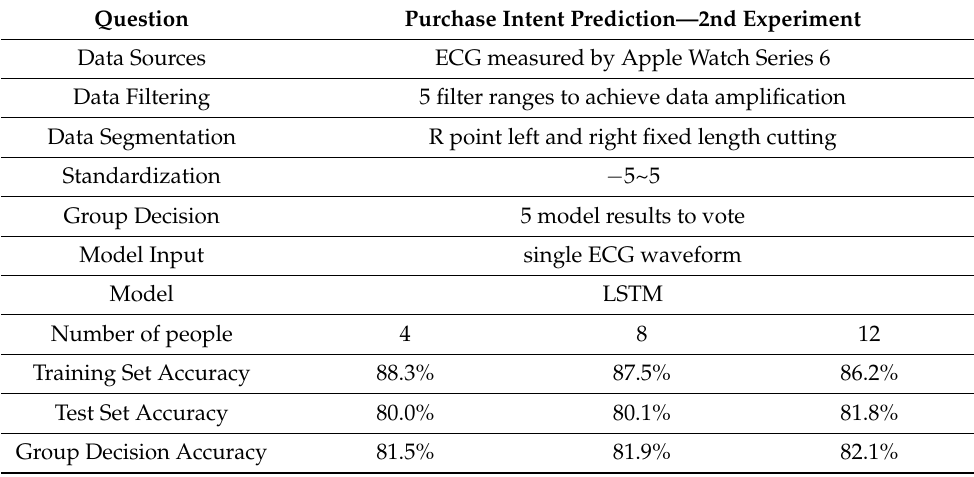
Table 4. Comparison of the experimental results in the second